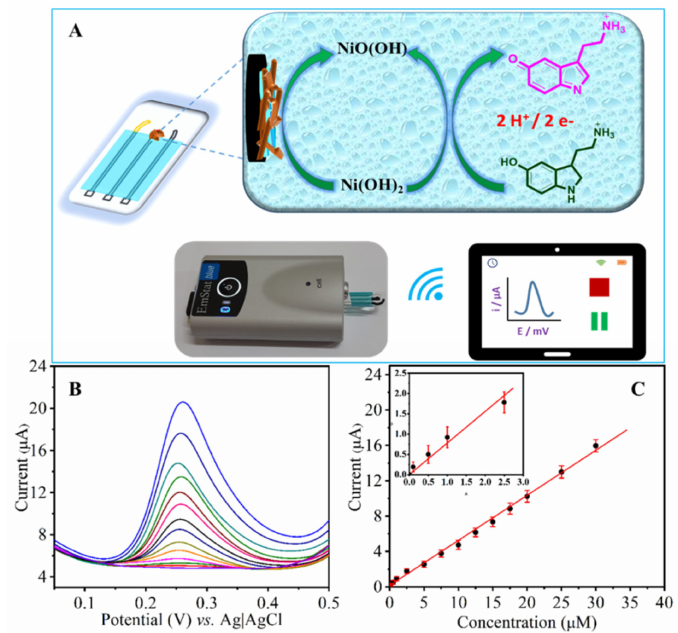
Figure 6. ( A ) Schematic representation of the electrochemical oxidation mechanism of 5-HT at the NH-HNP-Chit/SPCE and data collection with a portable, wireless potentiostat. ( B ) DPV of 5-HT at the NH-HNP-Chit/SPCE in a 0.1 M phosphate buffer solution (pH 7.4) at different concentrations (0.1–30 µ M). ( C ). The plot of peak current against the concentration of 5-HT.